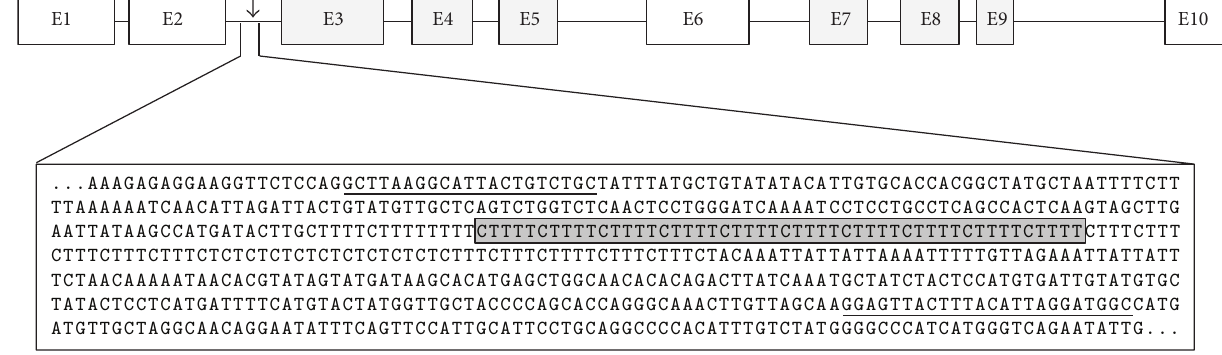
Figure 2: Daf1 gene organization showing location of the CTTTT n tandem repeat. Diagrammatic representation of exons (E) in Daf1 (top) and the expanded region of sequence in intron 2 (bottom) showing the CTTTT tandem repeat (shaded box) and PCR primers sequences (underlined). DNA sequence is from the C57BL/6 genomic sequence which has ten CTTTT repeats. Note that the repeat can also be represented by TTTTC by simple removal of the C residue at the 5 󸀠 end and inclusion of the C at the 3 󸀠 end. DBA/2 mice had the longest repeat sequence with CTTTT (or TTTTC) being repeated 11 times. NZB, NZW, BXSB, B10.S, C57BL/6, A.SW/Sn, BALB/c, and 129S6 mice had 10 repeats while MRL- 𝐹𝑎𝑠 𝑙𝑝𝑟 and SJL/J lacked the repeat.